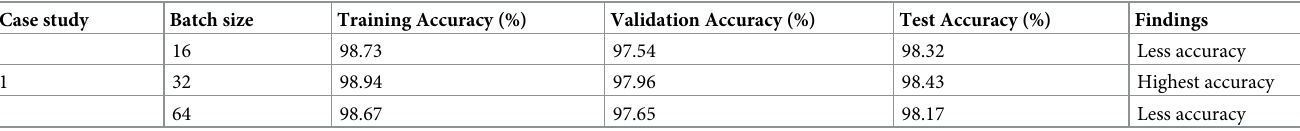
Table 9. Performance analysis by changing batch